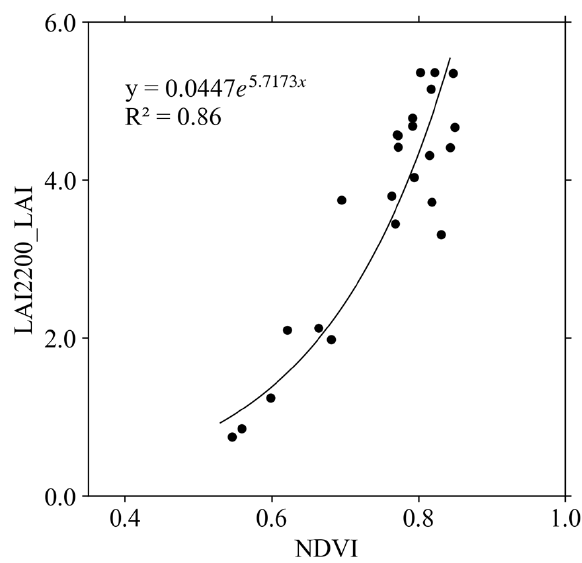
Figure 4. Regression between in ‐ situ measured LAI and